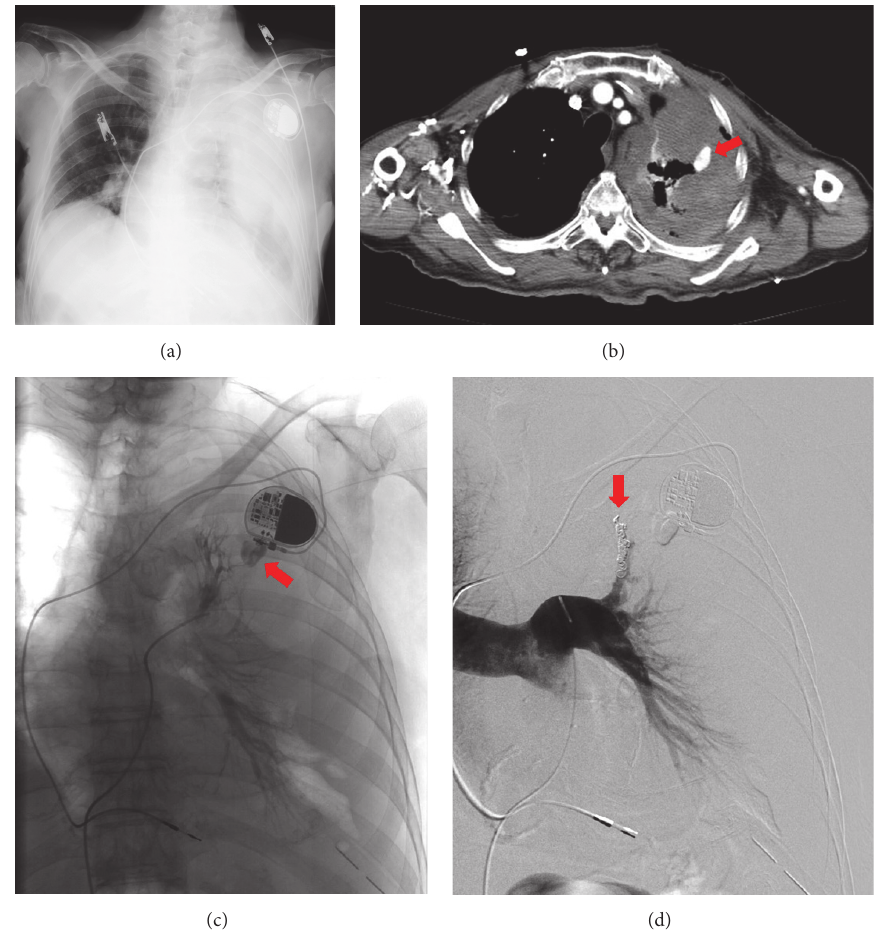
Figure 1: A 90-year-old man received a permanent implanted pacemaker. After the procedure, the patient’s blood pressure steadily decreased. Left hemothorax and laceration of the pulmonary arterial branch of the left upper lobe were confirmed. (a) Chest radiograph showed a left hemothorax. (b) Contrast-enhanced computed tomography (CT) showed a confined cavity (pseudoaneurysm) of a branch of the upper lobe pulmonary artery (arrow). (c) Angiography demonstrated bleeding from the perforated pulmonary arterial branch of the left upper lobe (arrow). (d) Transcatheter arterial embolization (TAE) was performed using microcoils (arrow). Digital subtraction angiographic image taken after coil embolization discloses coils (arrows) in the upper lobe pulmonary artery and no further opacification of the